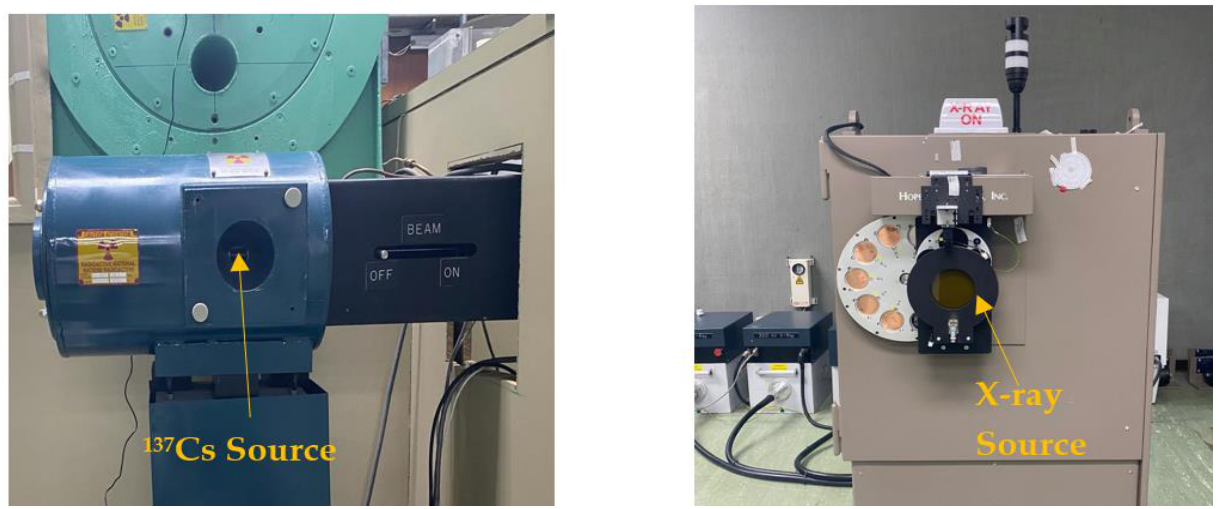
Figure 2. KFSH&RC-SSDL 450 Ci 137Cs and X-ray sources.